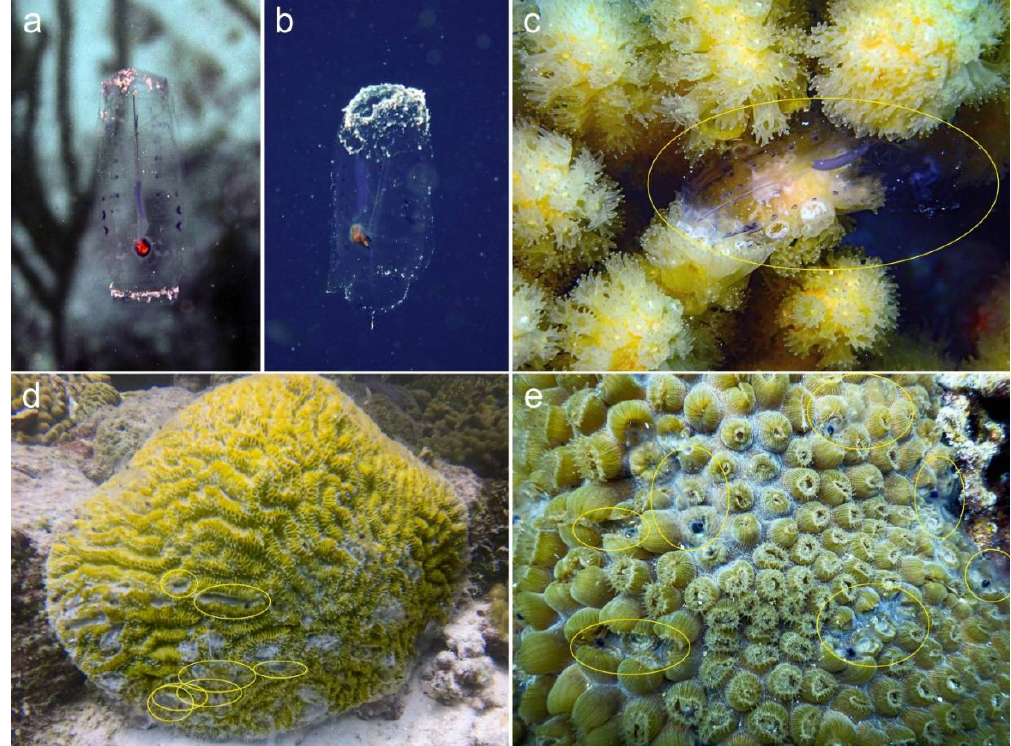
Figure 1. Salpivory by scleractinian corals at the coral reef in Director’s Bay, Curaçao. ( a , b ) Solitary zooids of Salpidae sp. above the reef; test length: ca. 5 cm. ( c ) A salp (marked by yellow ellipse) trapped by several polyps in a branching colony of Madracis auretenra . ( d ) A large number of salps (some marked by yellow ellipses) caught by a massive coral colony of Meandrina meandrites . ( e ) A few salps (yellow ellipses) captured by a massive colony of Montastraea cavernosa. Photo credits: ( a , b ): Jason Baer; ( c ): LJVtH; ( d ): Mark Little; ( e ): Antoni Luque.